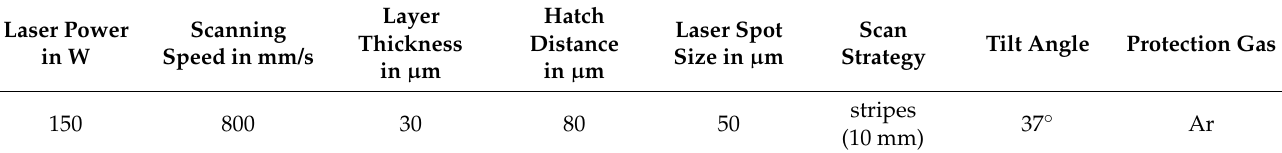
Table 3. Used PBF-LB/M process